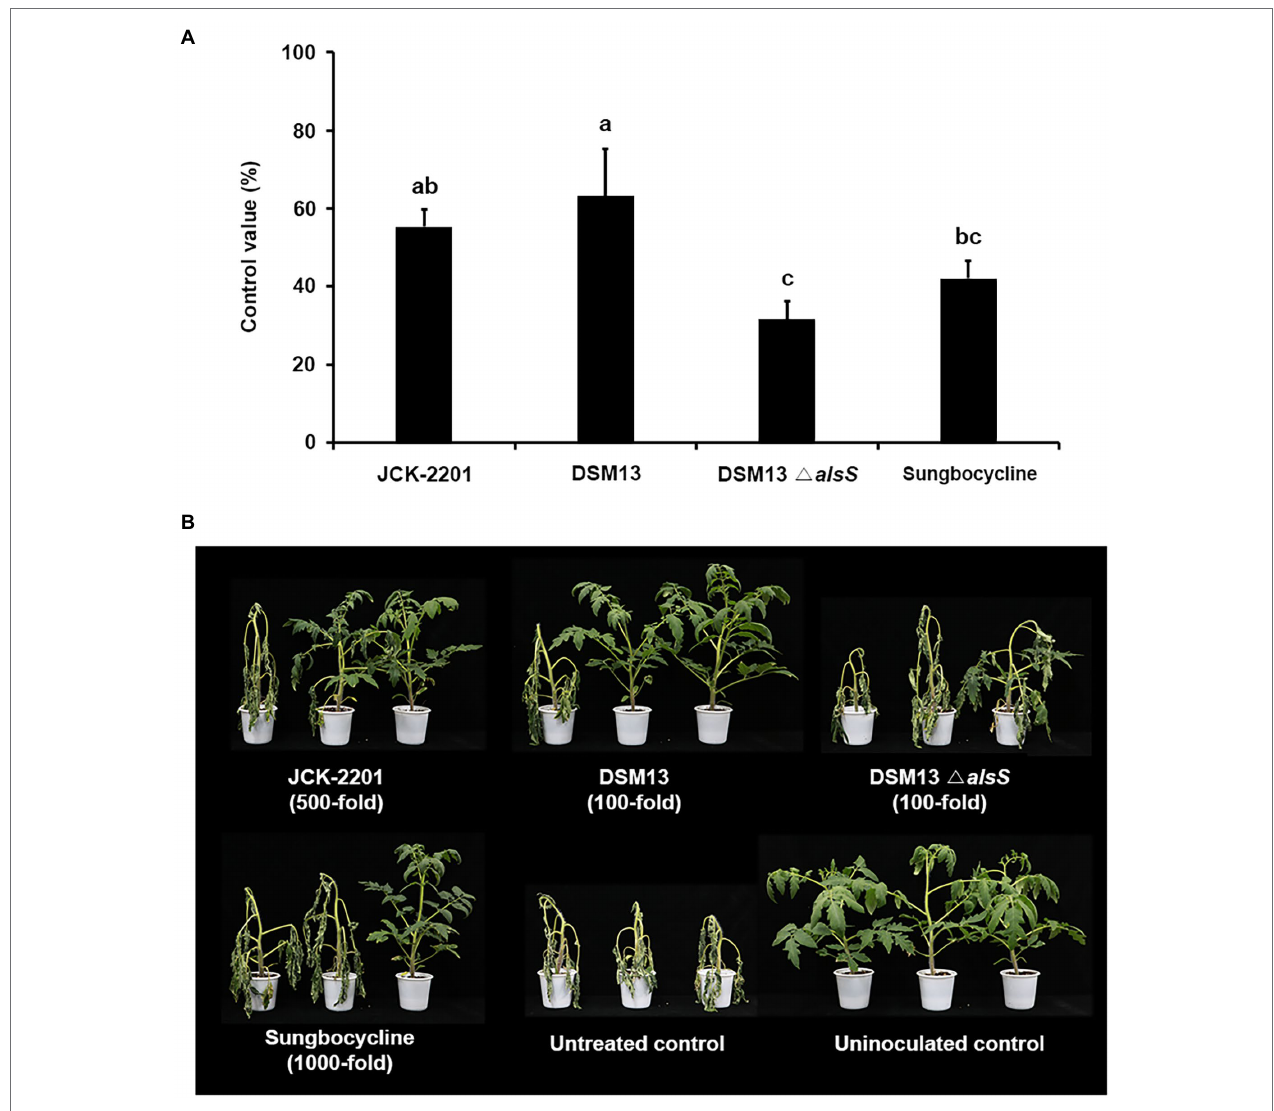
FIGURE 3 | Disease control efficacy of culture supernatant of K. pneumoniae JCK-2201, B. licheniformis DSM13, and B. licheniformis DSM13 Δ alsS on tomato bacterial wilt caused by R. solanacearum . (A) Control value was investigated 7 days after pathogen inoculation. The data show the means ± SD ( n = 3). Lower-case letters indicate statistically significant differences as compared to untreated control plants ( p < 0.05) according to Tukey’s HSD test. Error bars indicate the SDs. (B) Representative photographs of tomato seedlings at 7 days after inoculation of R. solanacearum by soil drench. As a positive control, plants were treated with